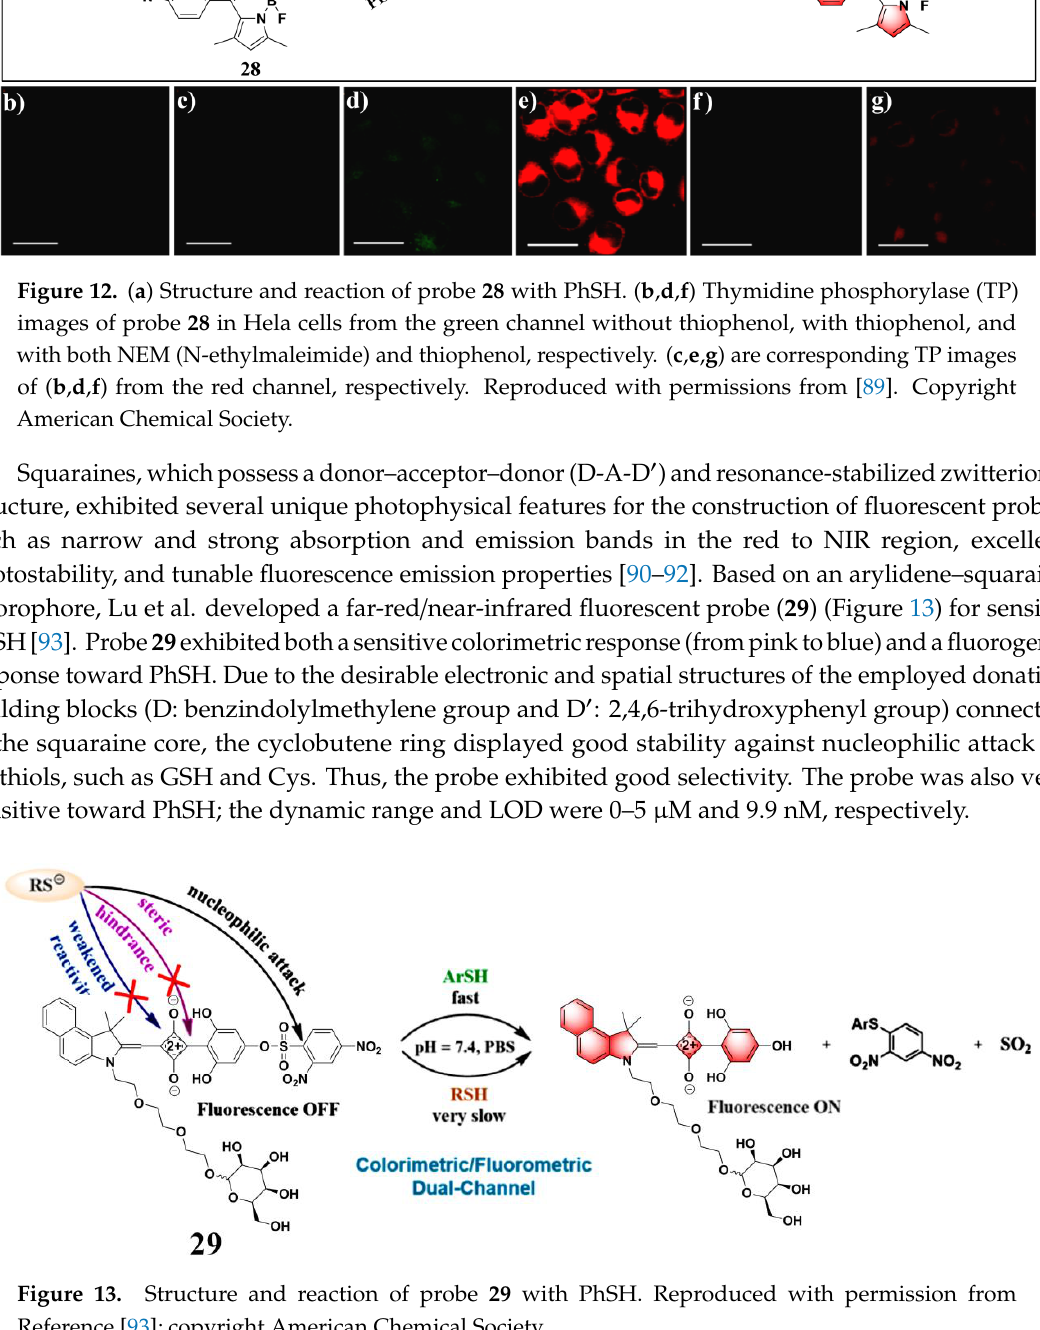
8 of 30 Figure 11. Structure and the sensing mechanism of probe 27 for PhSH.